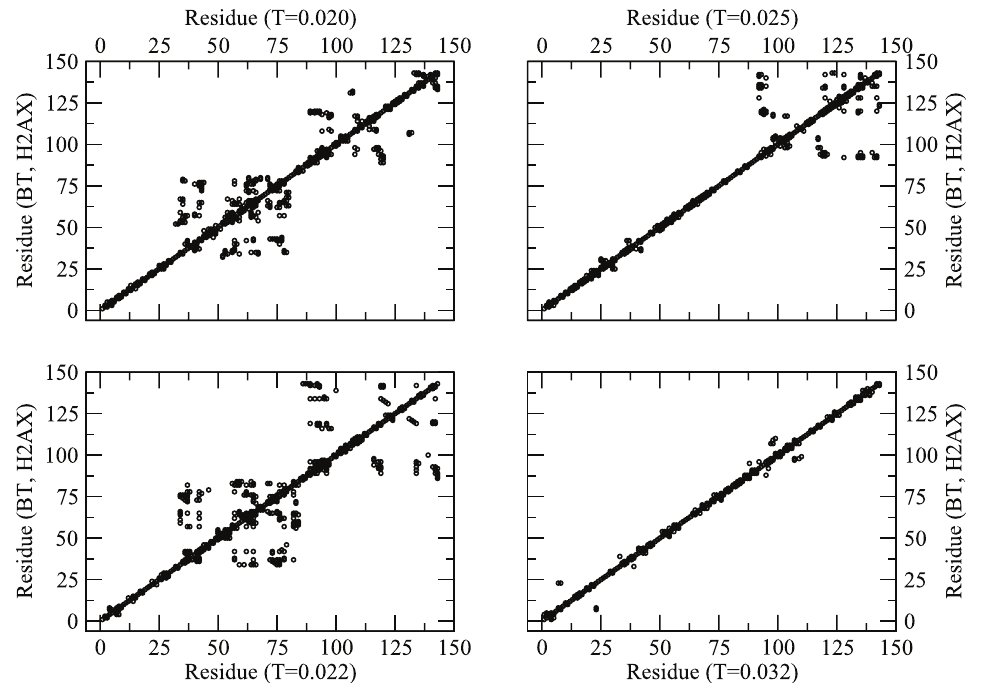
Figure 2. Residue map (neighboring residues along the contour within the range of interaction) of the protein at different temperatures ( T=0.020–0.032 corresponding to figure 1) with BT potential.